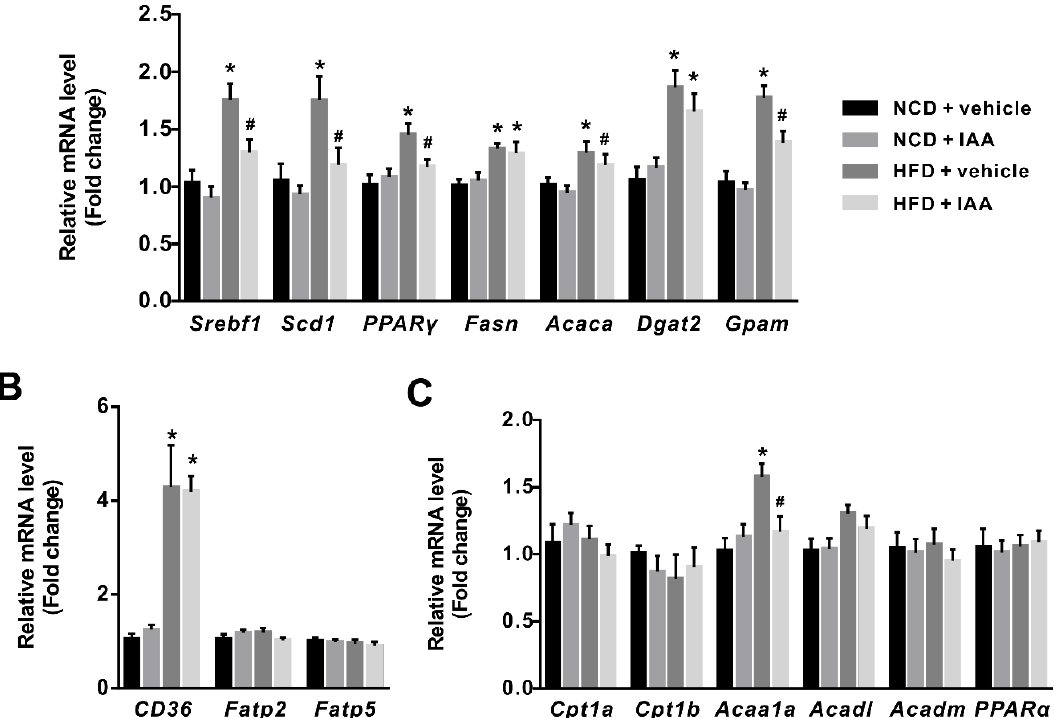
Figure 4. E ff ect of indole-3-acetic acid (IAA) on genes involved in lipid metabolism in liver of mice fed with normal chow diet (NCD) or high-fat diet (HFD). The relative expression levels of genes related to ( A ) lipogenesis, ( B ) fatty acid uptake, and ( C ) β -oxidation of fatty acids were quantified by RT-qPCR. The bar chart presents mean ± standard error of the mean of the fold change values acquired from at least 6 biologically replicates for each gene. * p < 0.05 vs. NCD + vehicle; # p < 0.05 vs. HFD + vehicle.